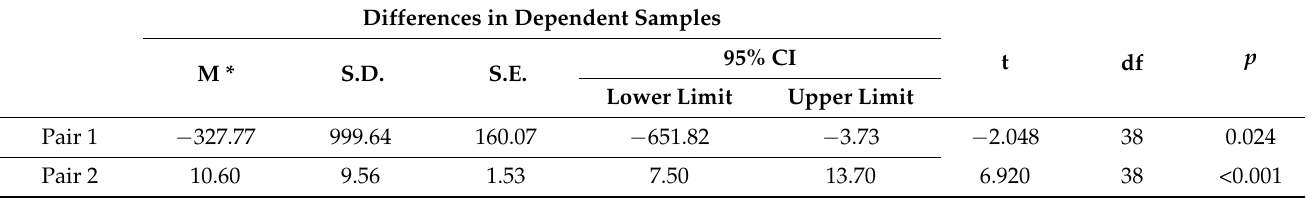
Table 3. Test for dependent samples.